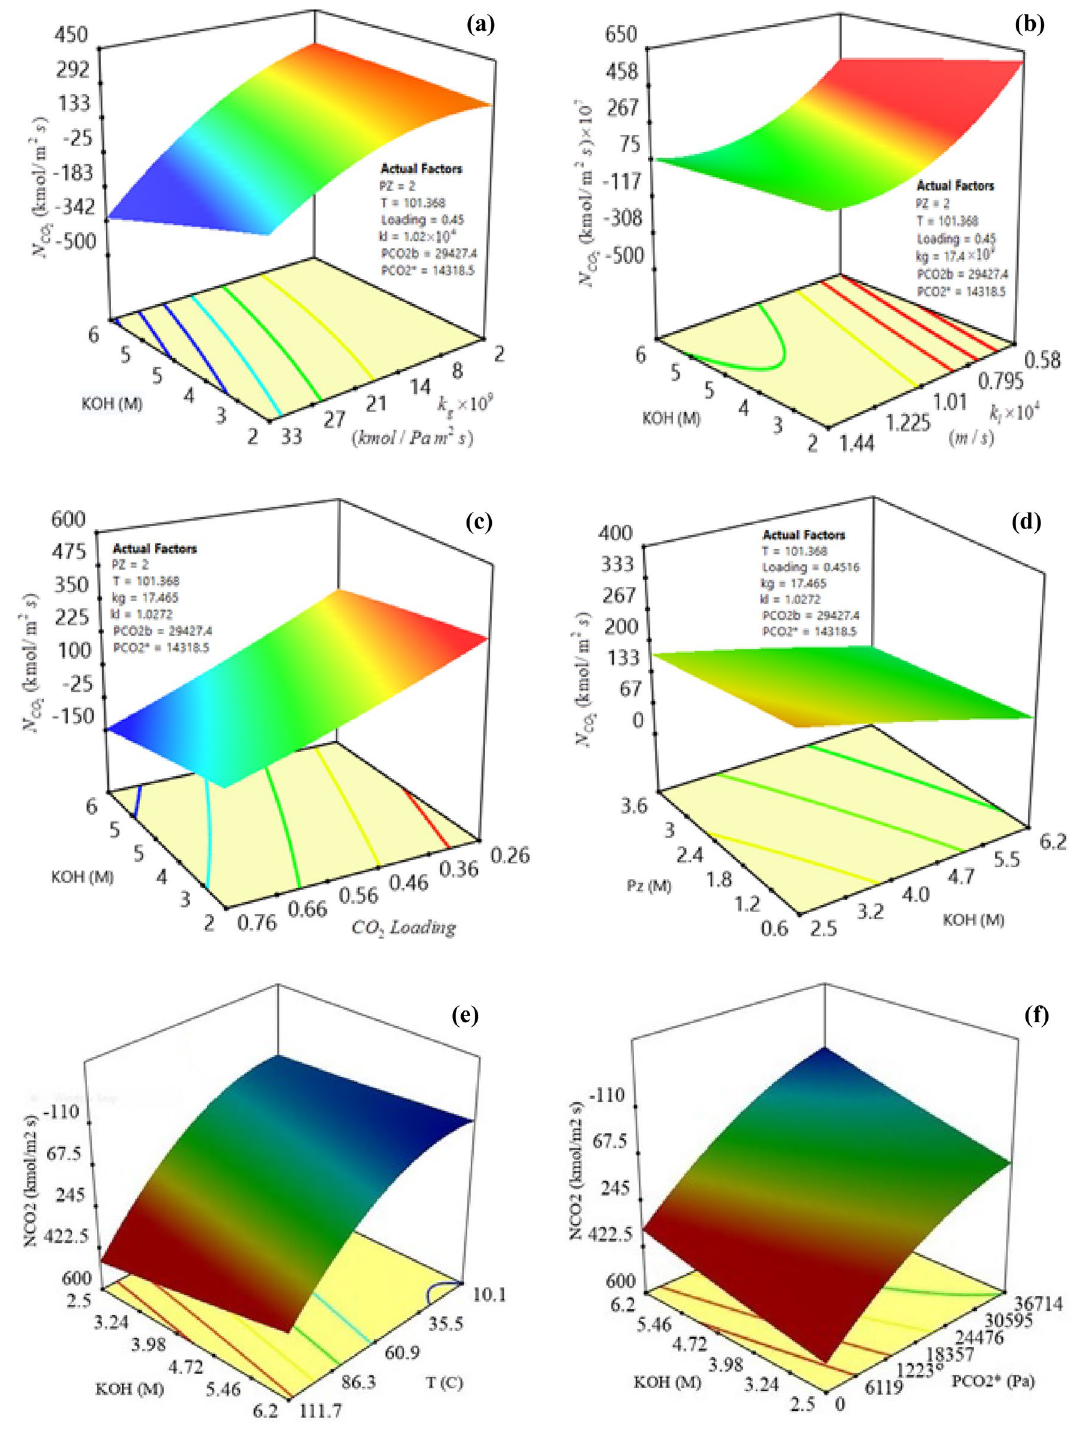
Figure 4. Response surfaces plots of CO 2 transfer flux variation with KOH concentration as a function of; ( a ) gas film side mass transfer coefficient, ( b ) liquid film side mass transfer coefficient, ( c ) CO 2 loading, ( d ) Pz concentration, ( e ) temperature, and ( f ) equilibrium CO 2 partial